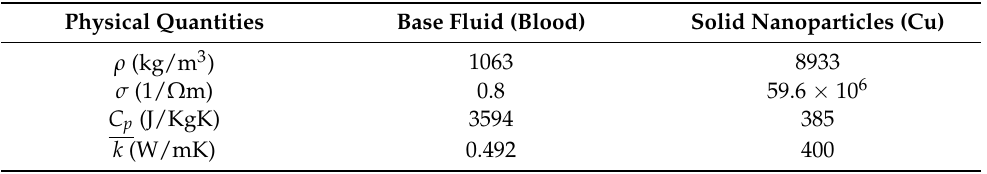
Table 1. Thermophysical characteristics of base fluid and nano bits